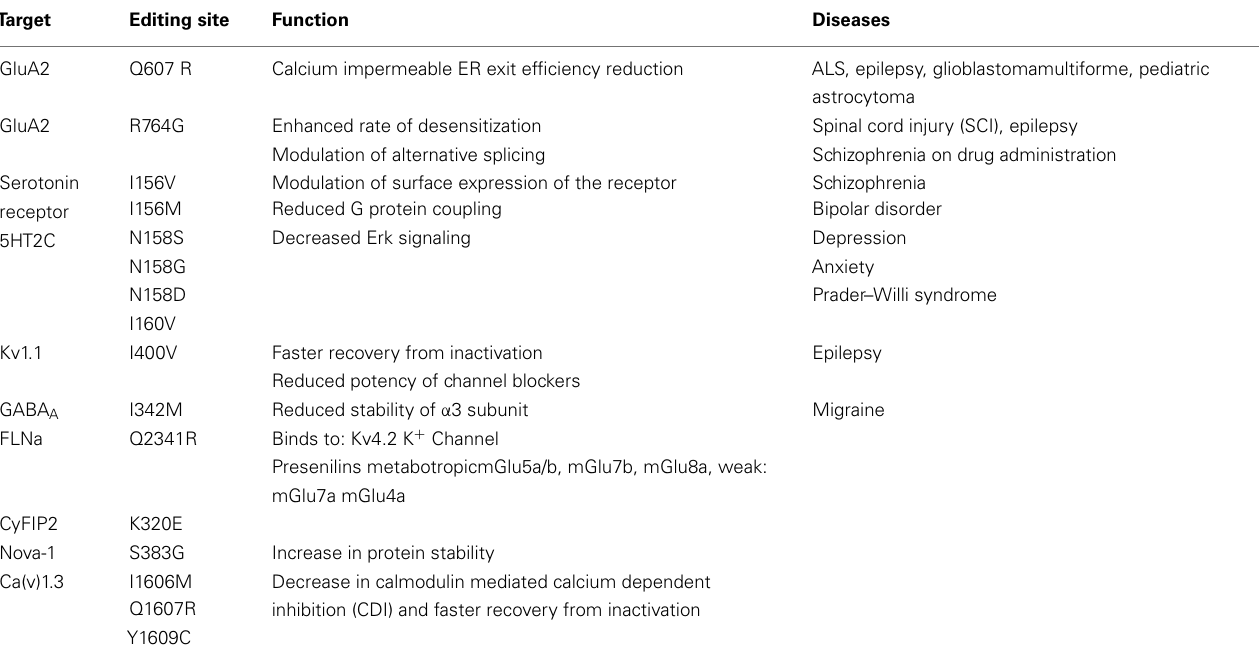
Table 1 | Selected editing events in the